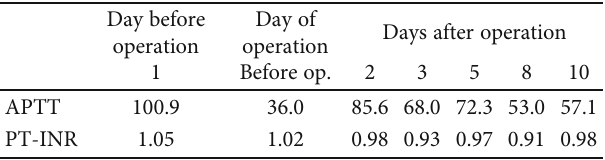
The results for APTT measurements are expressed in seconds. APTT: activated partial thromboplastin time; PT-INR: prothrombin time- international normalized